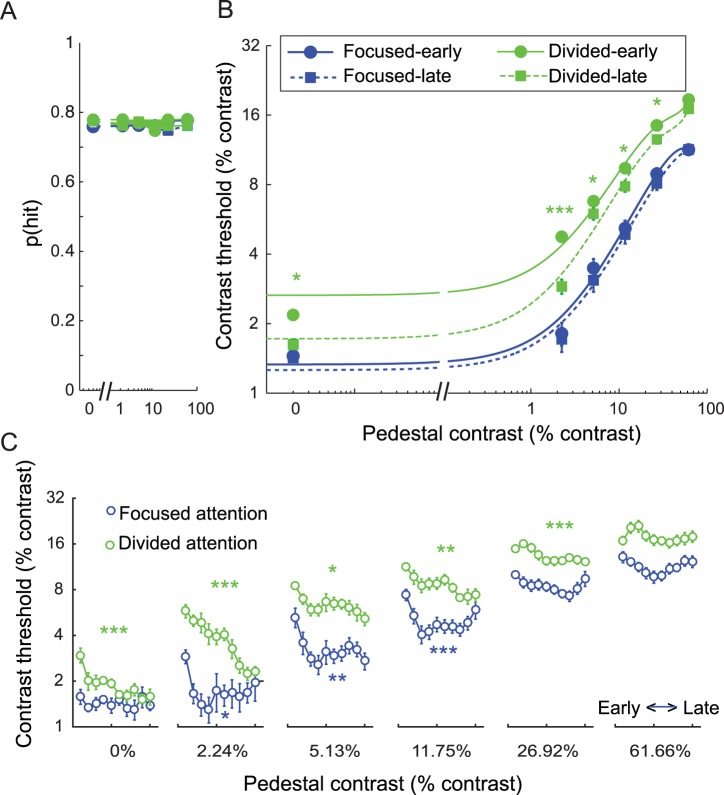
Behavioral results.(A) The hit rate was fixed at ~76% (d’ = ~1) across all conditions so that contrast discrimination thresholds could be measured as a function of attention and training. Error bars represent within-subject SEM. (B) Psychophysical contrast discrimination thresholds (Δc) for stimuli across all pedestal contrast levels in the focused and divided attention conditions split into early and a late training phases (10 electroencephalography [EEG] sessions for each phase). Error bars represent within-subject SEM. Green *, **, and *** in (B) represent pairwise differences between contrast thresholds in the divided attention condition across training phases with p’s < 0.05, < 0.01, and < 0.001, respectively (false discovery rate [FDR]-corrected). (C) The day-by-day Δc data showing a faster learning rate in the focused attention condition compared to the divided attention condition (2 EEG sessions or ~1 day of experiment per time bin). Error bars represent within-subject SEM. Blue and green *, **, and *** in (C) represent significant changes in Δc across days in the focused and divided attention conditions with p’s < 0.05, < 0.01, and < 0.001, respectively (FDR-corrected). Data are available from the Open Science Framework (https://osf.io/pc7dr/).